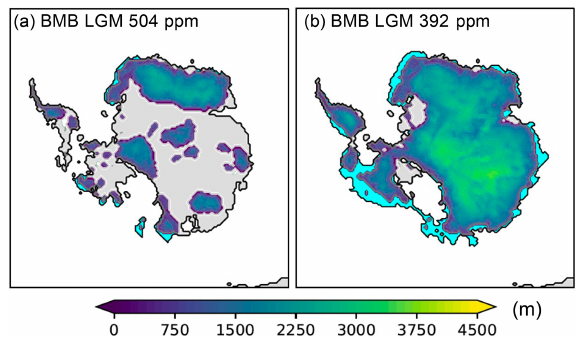
Figure 7. (a) Simulated equilibrated grounded ice thickness from experiment BMB LGM with 504ppm and (b) 392ppm CO 2 forc- ing, starting without ice. Cyan areas indicate ice shelf extent and grey areas ice-free